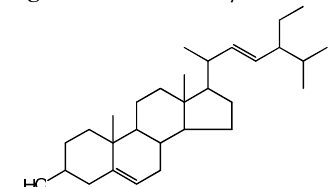
Figure 3. Structure of β -sitosterol